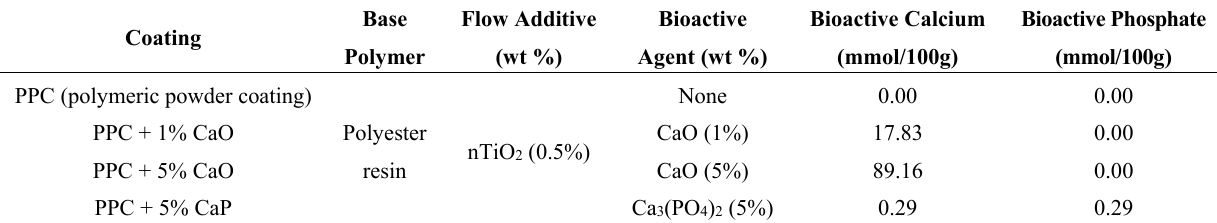
Table 1. An example of the enhancement particle